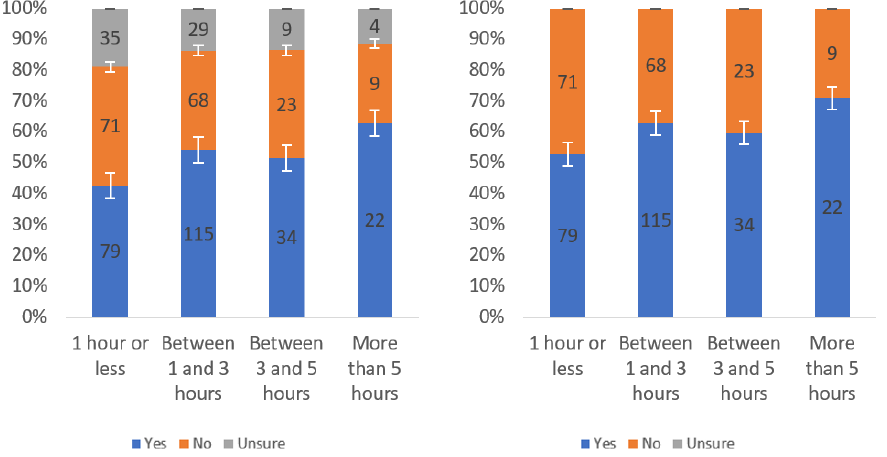
Figure 63. Responses regarding respondents’ willingness to review by internet usage level including ( left ) and excluding ( right ) unsure responses.